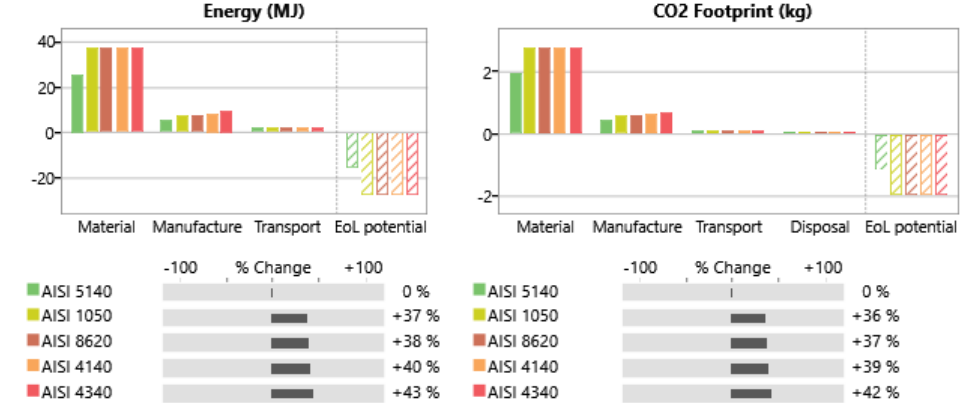
Figure 2. LCA comparison chart. Table 7. Entropy matrix P ij .